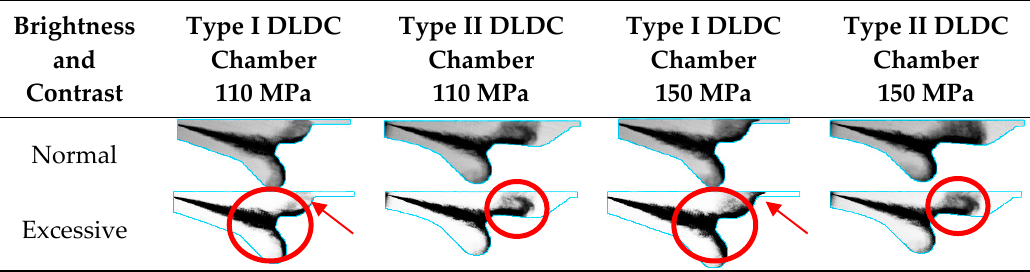
Figure 10. The comparison of fuel spray distributions at 1.4 ms ASOI (after start of injection) under different brightness and contrast with medium load, Φ 0.16 mm nozzle, different injection pressures and 5 °CA BTDC injection timing of Mode A.